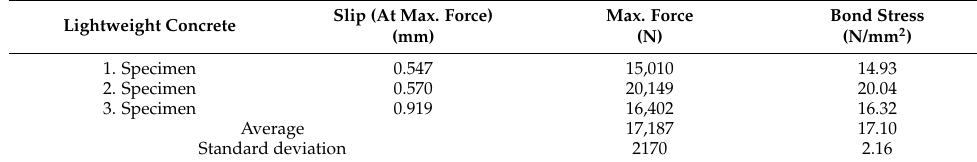
Table 5. Bond stress of lightweight concrete.